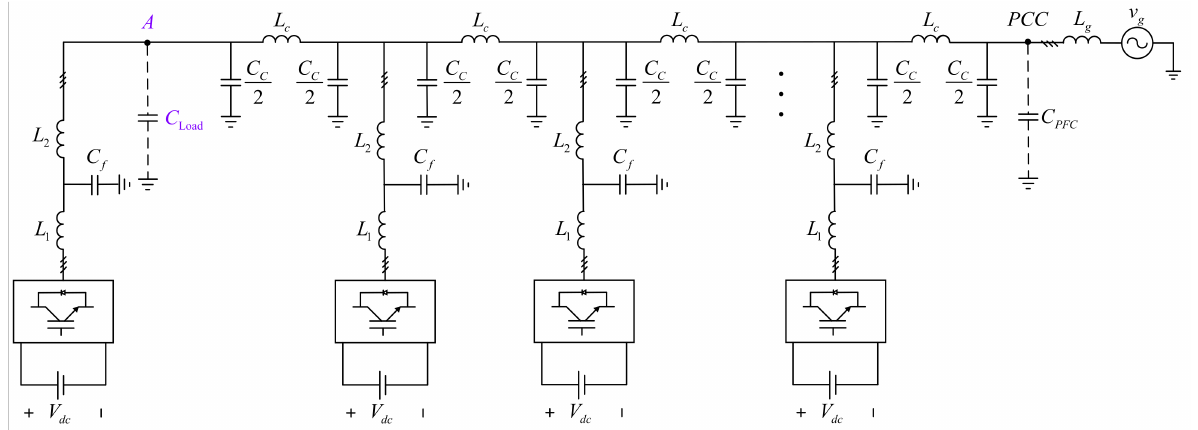
Figure 20. Per-phase diagram of multiple inverters connected to the grid [28].